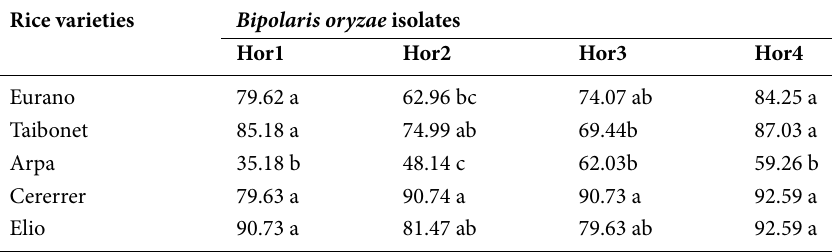
Table 7 Mean percentages of disease severity induced by Bipolaris oryzae isolates in rice varieties.